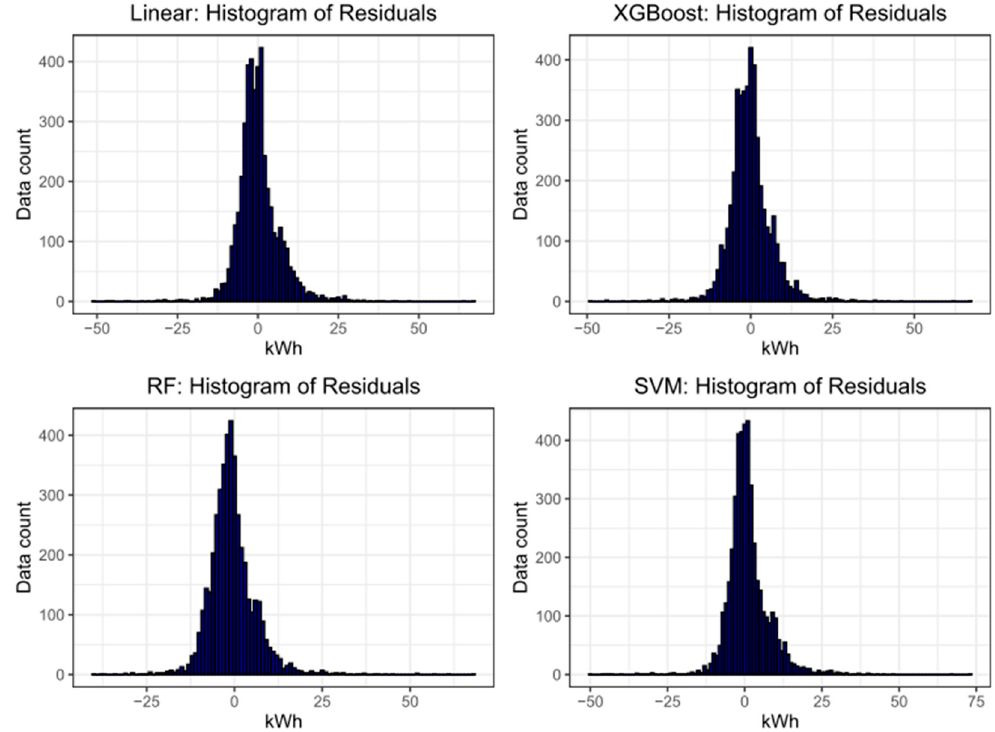
Figure 9. Histograms for the residuals of each method, in 1 kWh increments.